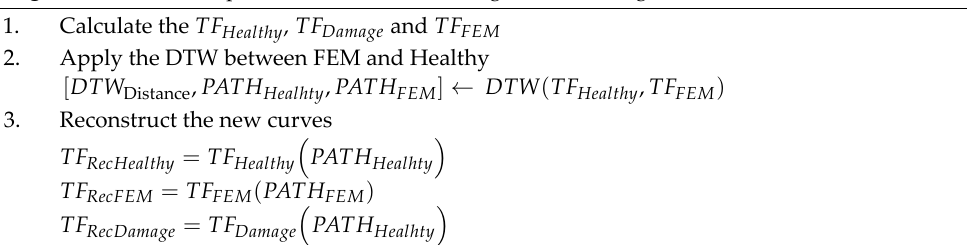
Algorithm 3. Main steps to reconstruct the damaged curve using the DTW.